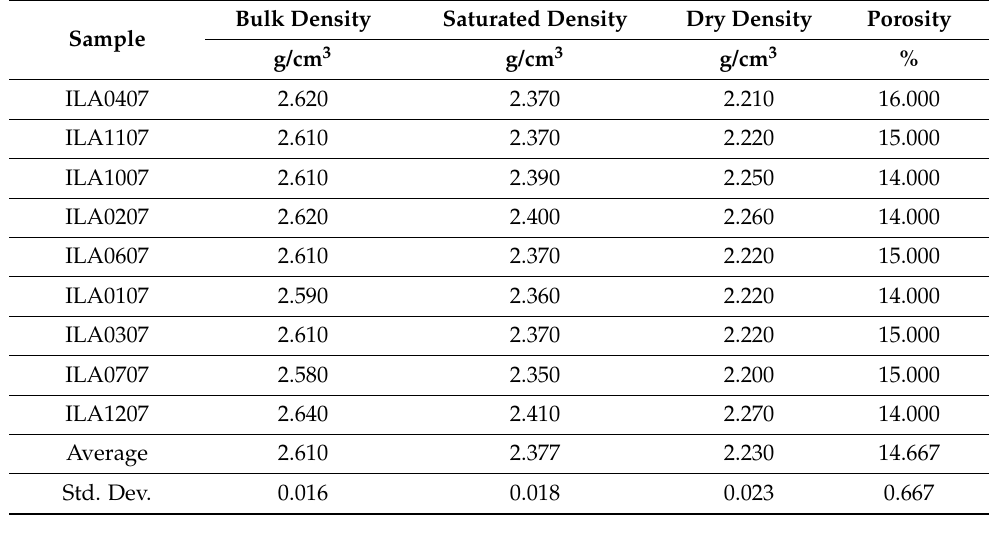
Table 1. Density and porosity of 10 Indiana limestone samples.